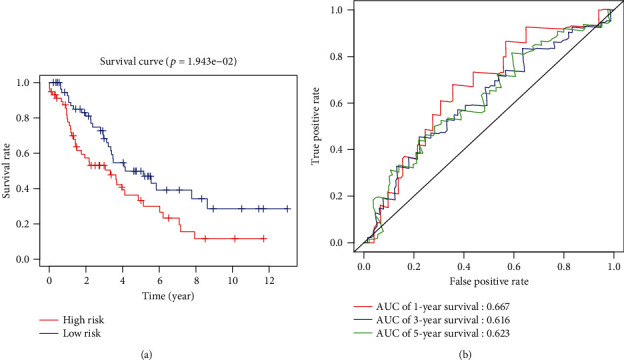
Verification of stability and validity of the prognostic model for LUAD with an independent dataset GSE26939. (a) Survival difference between the patients in the high- and low-risk groups was revealed by Kaplan-Meier analysis; (b) ROC curves of the 7-gene model using the independent dataset.